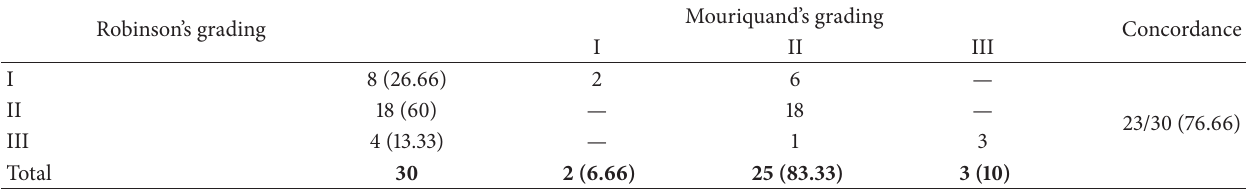
Table 2: Comparison of cytological grading by Robinson’s and Mouriquand’s methods. Robinson’s grading